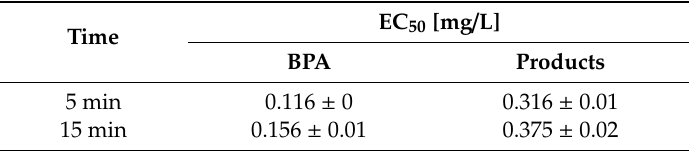
Table 5. Environmental toxicity of BPA and its transformation products obtained using Microtox ® test after 5 and 15 min of incubation with Vibrio fisheri and expressed as EC 50 . Time